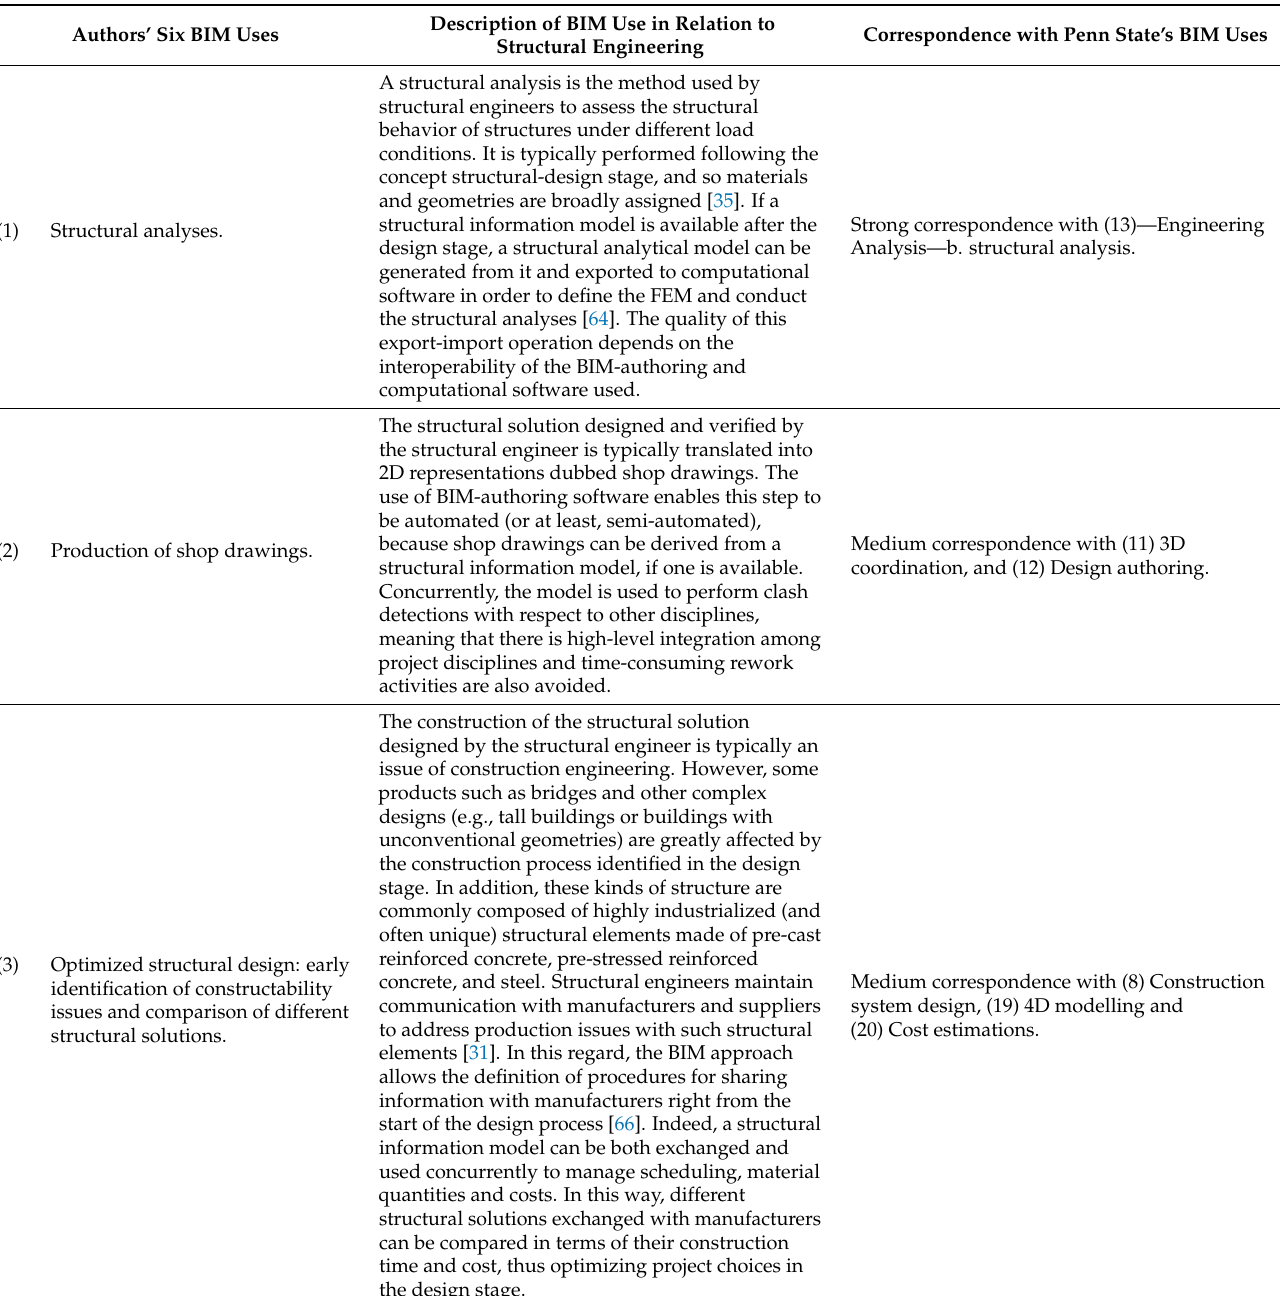
Table 2. Detailed description of the authors’ BIM uses in relation to structural engineering and a comparison with those of Penn State